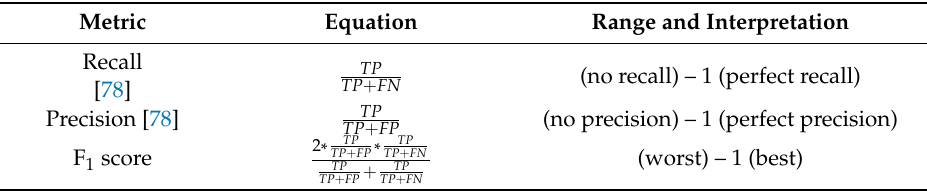
Table 3. Classification metrics used in assessing the model performance.